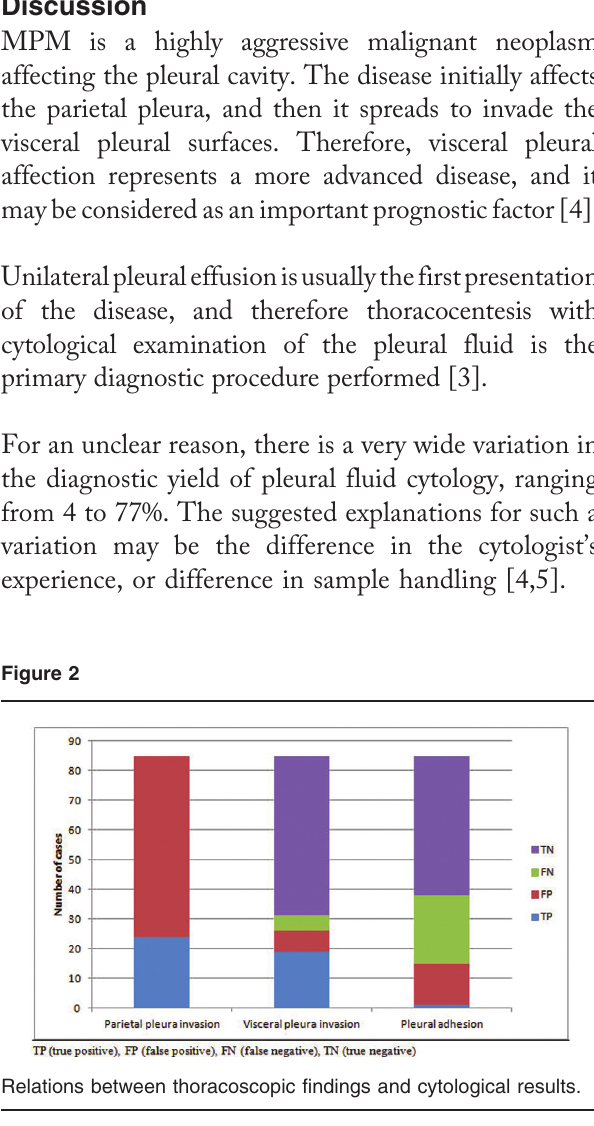
Table 2 Relation between pleural fluid cytology and subtype of malignant pleural mesothelioma Pleural fluid